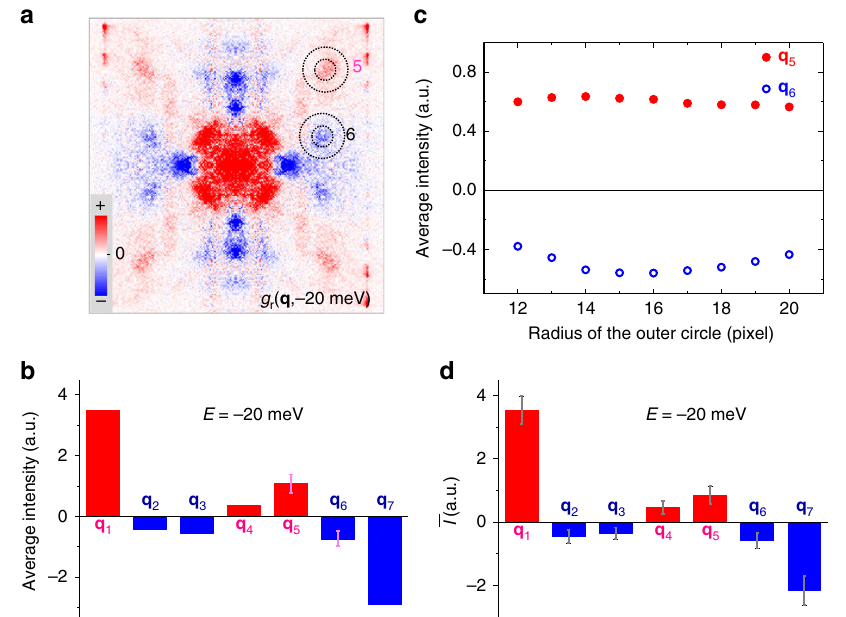
Fig. 6 Control experiments and error analysis of the PR-QPI signal. a Experimental PR-QPI pattern measured on another sample and analyzed by multi- DBS-QPI method. b Averaged intensity per pixel of PR-QPI signal for each scattering spot. c The averaged intensity of the PR-QPI signal within the two circles shown in a . This calculation for determining possible error bars is specially done for q 5 and q 6 spots with the increasing size of the outer circle. The averaged values of these data are taken as the error bars for q 5 and q 6 spots and shown in b . d The average of the intensities for each scattering spots measured in four areas of three samples at ±20 meV. The error bars in d are calculated through the standard deviations from the statistics. Note the error bars in b and d have different meanings. Those in b give the uncertainty of the PR-QPI intensity calculated for a particular scattering spot in one FOV. Those in d re fl ect the uncertainty among different FOVs and